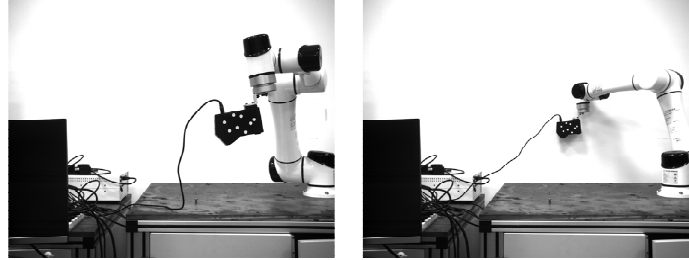
Figure 13. Left camera images at distances of 1.2 m and 2.3 m.